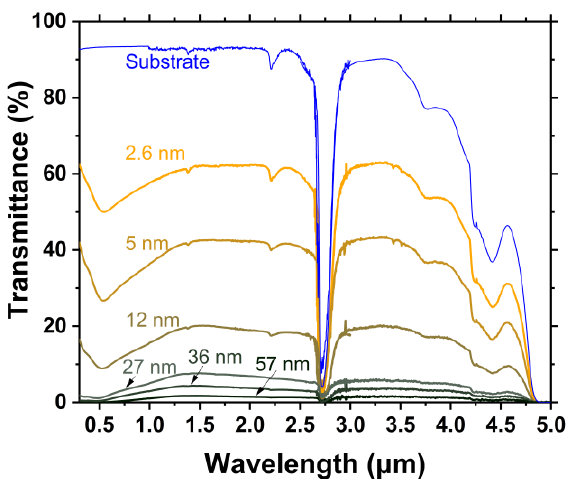
Figure 6. Ex situ UV-visible IR transmittance of bare fused silica substrate and of the samples with deposited Cr films of various thicknesses. deposited Cr films of various thicknesses.